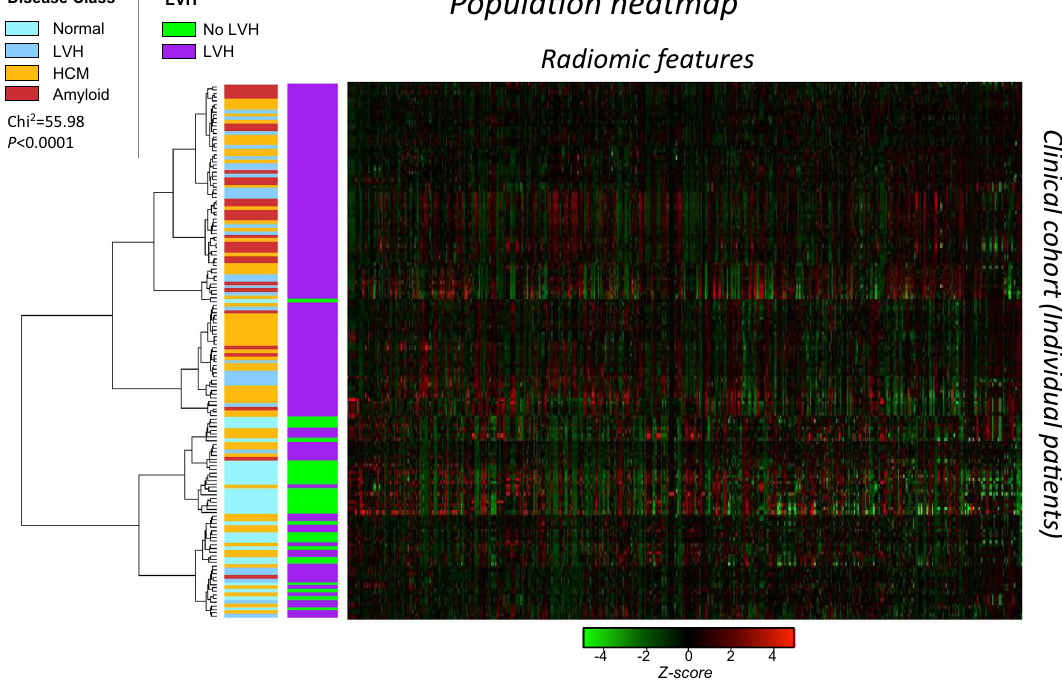
Figure 3. Unsupervised hierarchical clustering of patients of Arm 2 by T1 radiomics (n = 628) and resulting heat map with a row dendrogram indicating the patient clustering. Vertical colored legends on the left of the heat map indicate the cardiac phenotype for each observation (patient). HCM hypertrophic cardiomyopathy, LVH left ventricular hypertrophy. Chi 2 p value is reported for the difference in disease class between the two parent